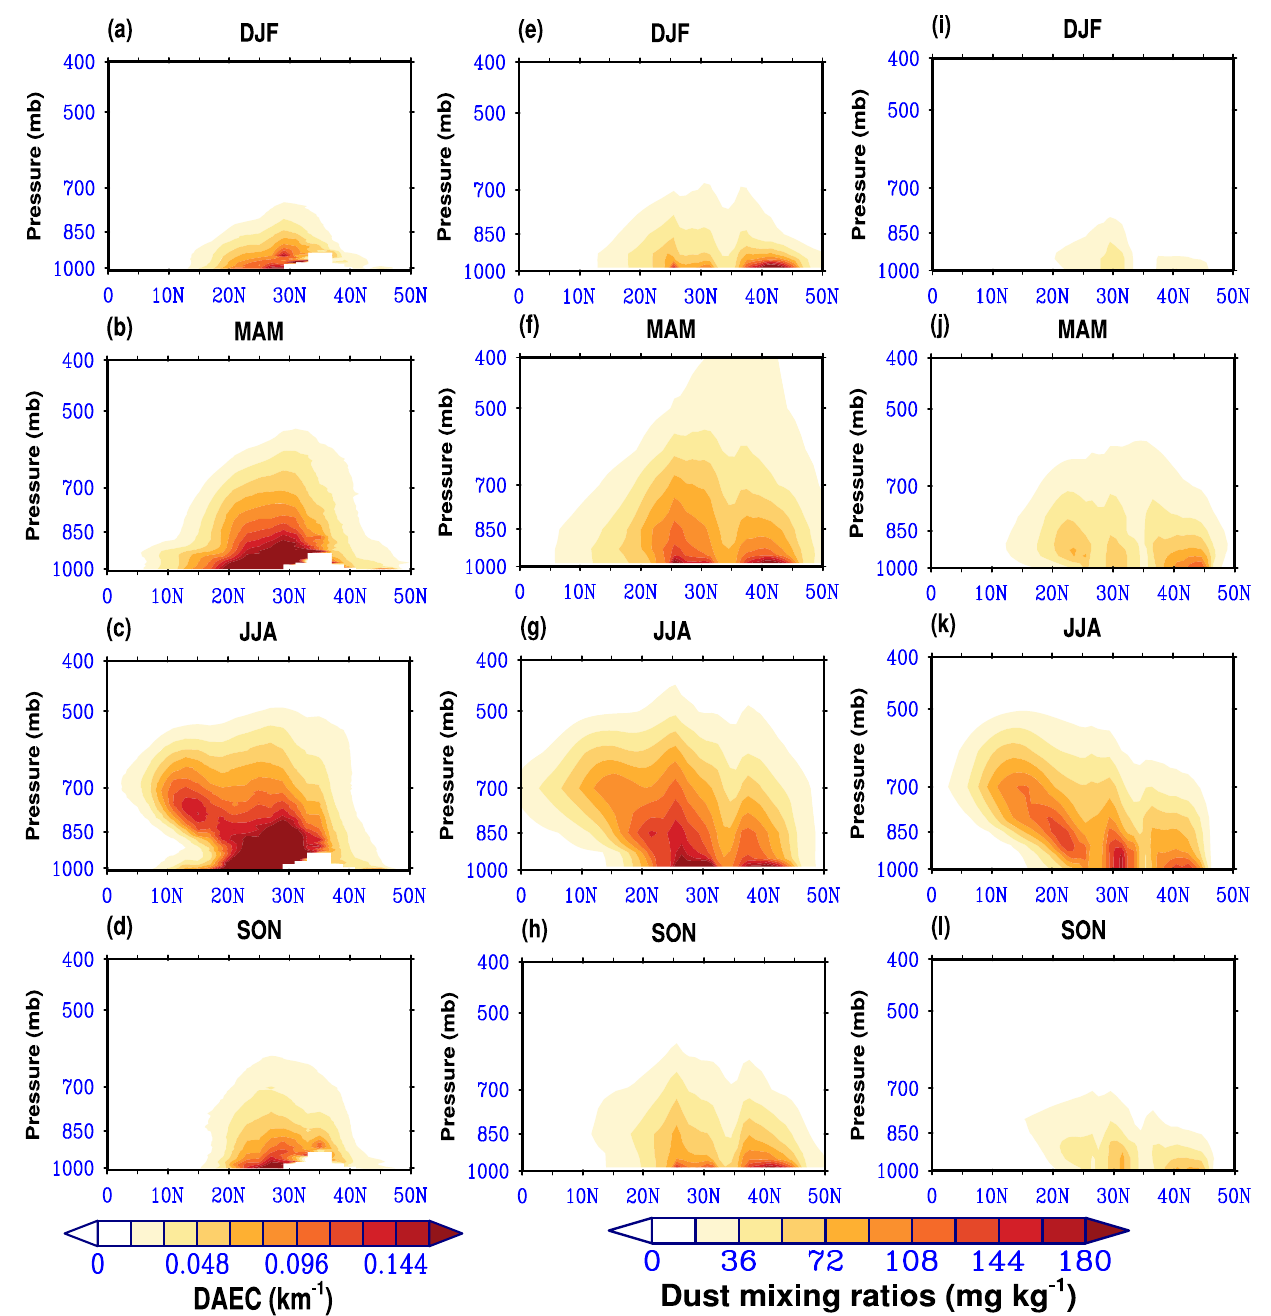
Fig. 5 Zonal climatology of dust aerosol distribution over Arabian Sea. Seasonal zonal climatology of dust aerosol extinction from CALIOP ( a – d ), and dust mixing ratios from MERRA-2 ( e – h ) and CAMS ( i – l ) over the Arabian Sea (zonally averaged between 60°E and 70°E) during the period 2007 –